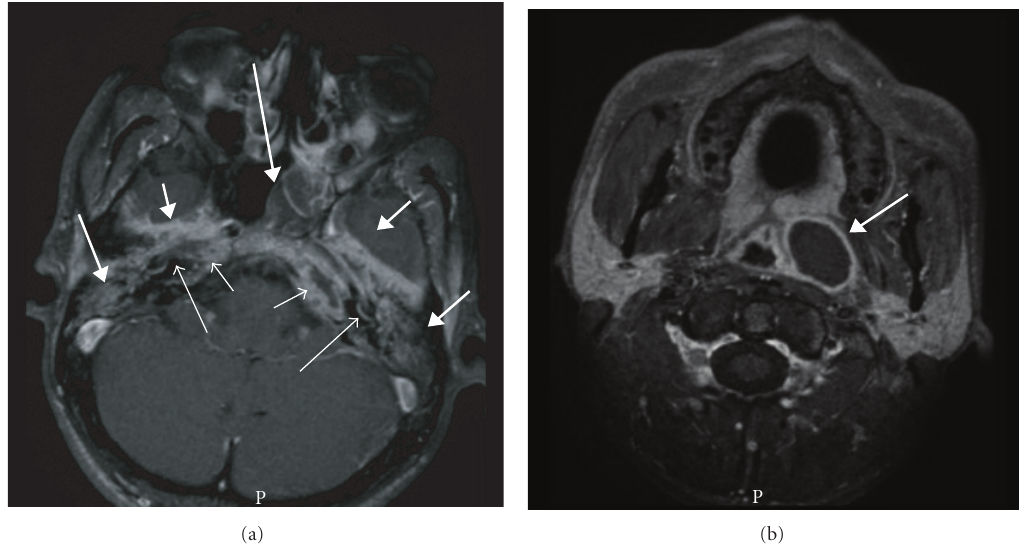
Figure 1: (Case A) Axial T1-weighted MR image with fat suppression after administration of Gadolinium at the level of the petrous bones (a) and just below the skull base (b). Indicated in a are the bilateral inflammatory changes in the petrous apices (short open arrows), bilateral involvement of the basal turn of the cochlea (long open arrows), extensive bilateral pachymeningeal involvement at the temporal lobes (short closed arrows), opacification of both mastoids and middle ears (medium closed arrows), and the mass in the left middle nasal passage extending up to the left Eustachian tube as visualized during fiber endoscopy (long closed arrow). Extension of the abscess into the parapharyngeal space, resulting in a bulge of the contour of the nasopharynx, is also shown (b, medium closed